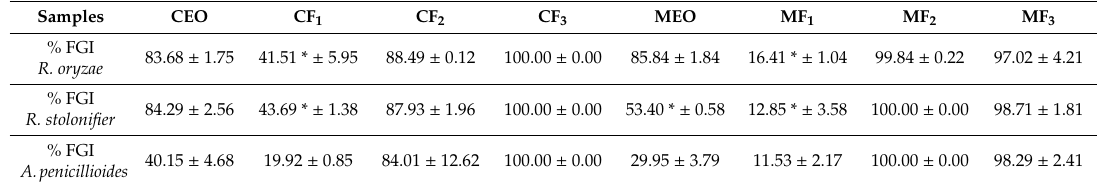
Table 2. Fungal growth inhibition (FGI %) of CEO and MEO against R. oryzae, R. stolonifier, and A.